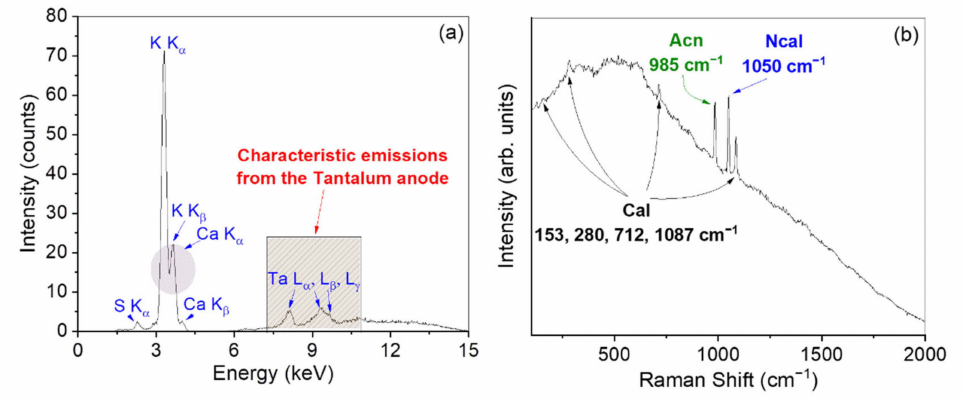
Figure 9. XRF spectrum recorded on the efflorescence ( a ). Raman spectrum recorded on the efflores- cence ( b ). In the figure, Acn: arcanite; NCal: nitrocalcite; Cal: calcite. Calcium carbonate, or calcite, individuated in the efflorescence is the product of a secondary recrystallization. Indeed, calcium carbonate is the main component of